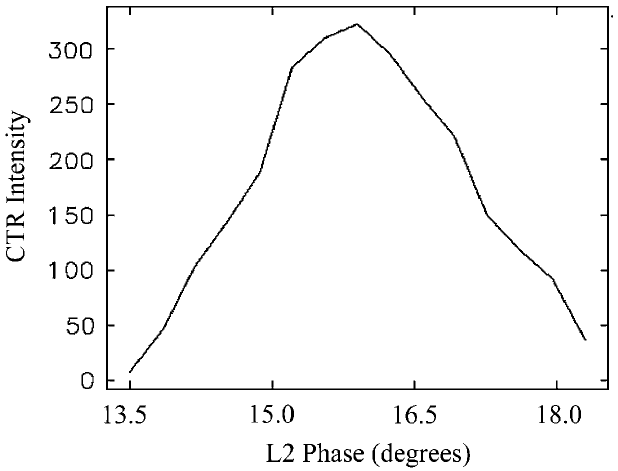
FIG. 2. Variation of FIR CTR signal from the Golay cell with the upstream L2 rf accelerator phase setting.